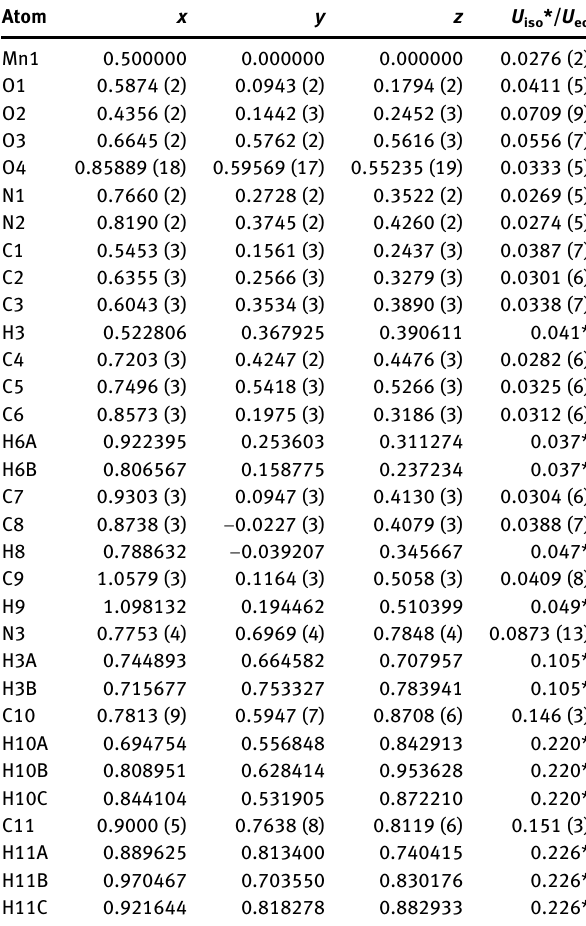
Table  : Fractional atomic coordinates and isotropic or equivalent isotropic displacement parameters (Å 